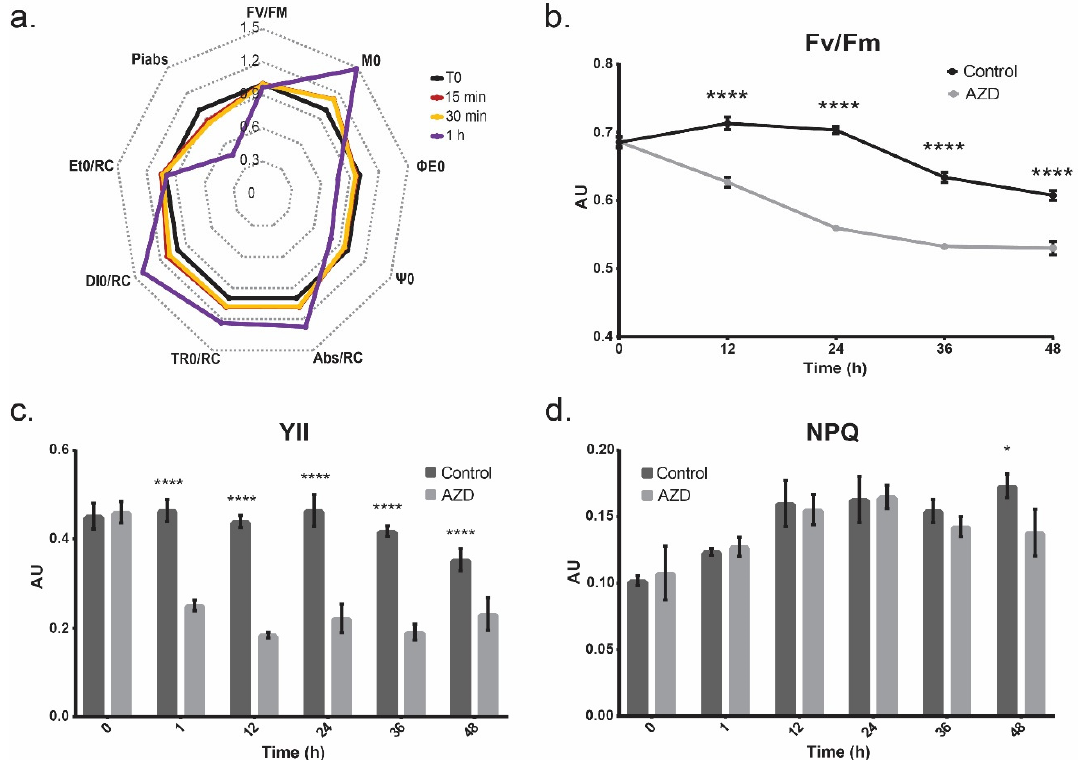
Figure 4. Photosynthesis measurements taken after treatment. The error bars represent standard deviation and statistical differences indicate a difference between the inhibited and non-inhibited cultures at one time point. Significance is denoted by asterisks, where * indicates p ≤ 0.05, and **** indicates p ≤ 0.0001. ( a .) Chl a fluorescence OJIP parameters of AZD-dosed cultures over the course of 1 h, where t0 is normalized to 1, enabling visualization of rapid changes in the photosynthetic apparatus. Changes in OJIP parameters relative to the control, as well as the derivations and explanations of all parameters, can be found in supplemental materials. ( b .) F V / F M , the measure of quantum e ffi ciency of PSII following dark adaptation, of the cultures with and without AZD treatment. ( c .) The photochemical yields of photosystem II with and without treatment with AZD8055 measured using PAM fluorescence. ( d .) The nonphotochemical quenching of the cultures with and without AZD8055 treatment measured using PAM